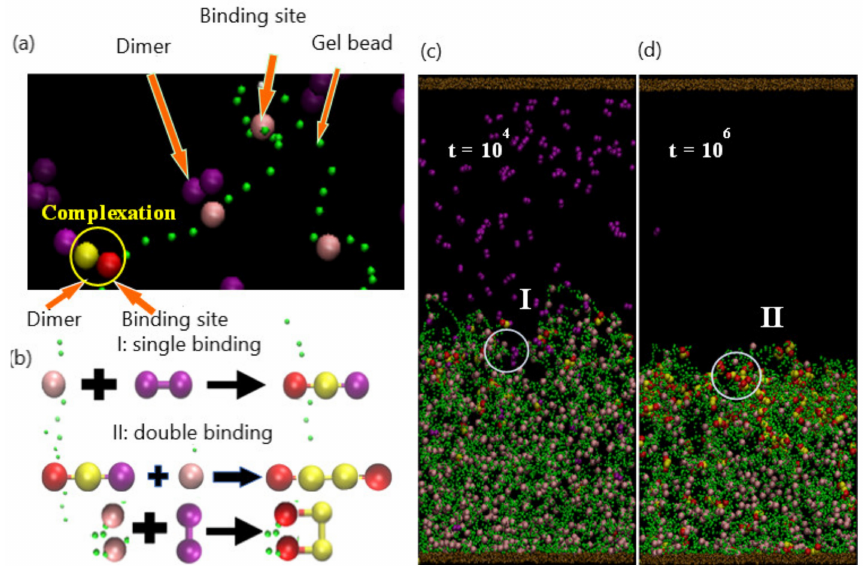
Figure 1. ( a ). Particle compositions of the system: dimer (purple), gel-binding site (pink), gel bead (green), and formed complexation group including a dimer bead (yellow) and a binding site (red). Beads sizes are tuned for better visualization. ( b ). Schematics for single binding (I) and double binding (II) between dimer and binding site. Double binding can be evolved from single binding or direct binding. ( c , d ). Snapshots of system ( N bind = 792, N dimer = 150) at early swelling stage ( t = 10 4 ) and late collapsing stage ( t = 10 6 ). Single and double bindings are observed in I and II, separately. Table 1. Color map for each bead and their interaction parameter with solvent ( a ). Color Bead Type Interaction with Solvent ( a